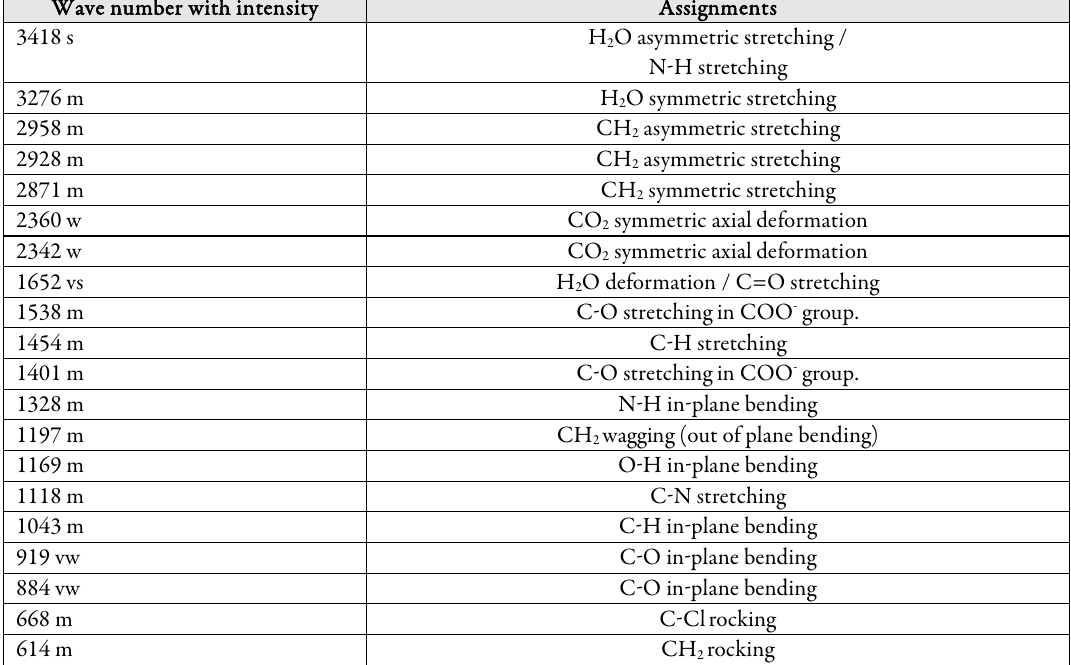
Table 4. The observed wave number, intensity and the probable vibrational assignments of the various compounds present in the mantle of S. pharaonis Wave number with intensity Assignments 3418 s H 2 O asymmetric stretching /